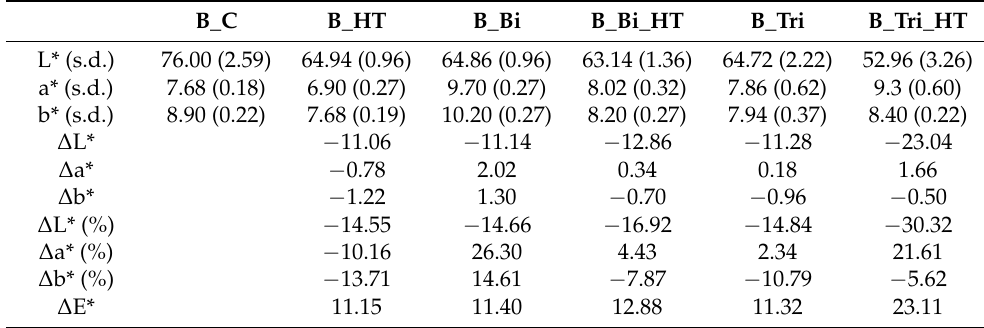
Table 2. Colour determinations of European beech (B) treated with bicine (Bi) and tricine (Tri), respectively. HT = thermal modification.